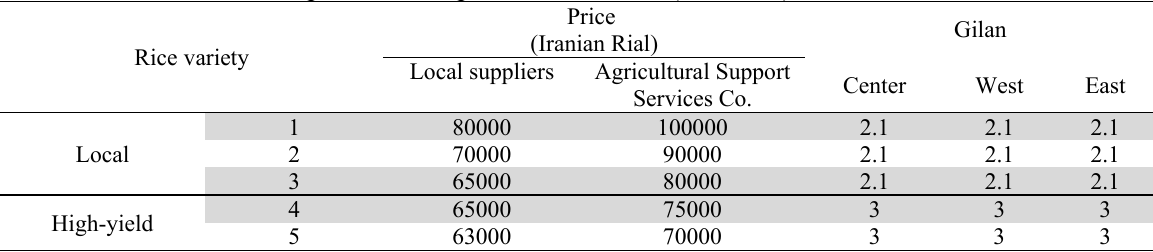
Yield of rice varieties, and procurement price of rice seeds (tones/ha 2 )